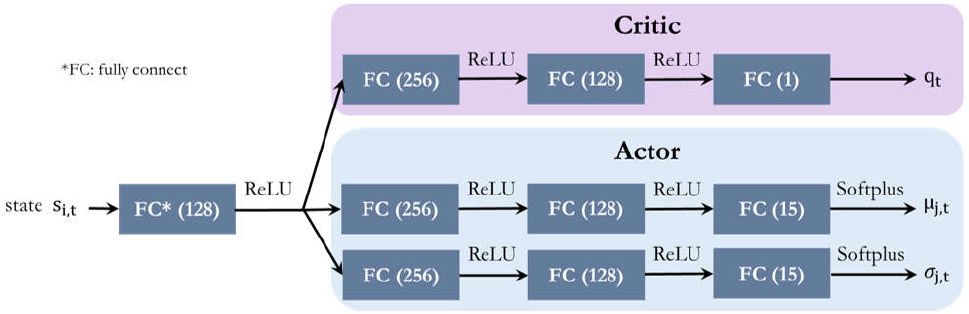
Figure 2. Structures of the actor and critic neural networks.